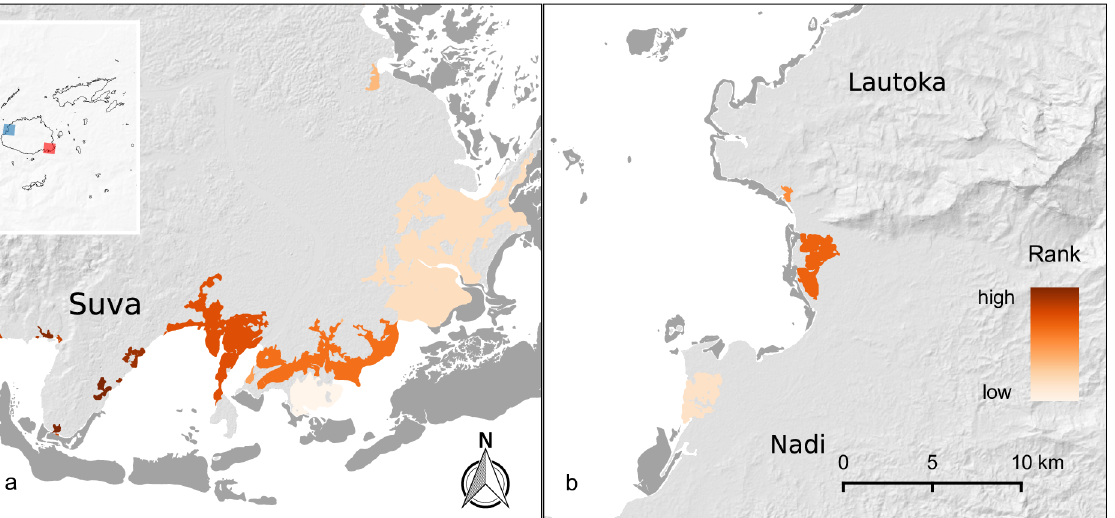
Fig 4. Ranking of priority sites for coastal protection services. Panel (a) (red inset polygon) centres on the greater Suva area; the darkest coloured areas are the highest ranked priority sites in Fiji. Panel (b) (blue inset polygon) centres on the Nadi and Lautoka area in the Western Division; populations are also high in the area, but many areas where mangroves may have existed have been cleared for coastal and resort development. Little development occurs behind extant mangroves in this area. Dark grey areas are corals